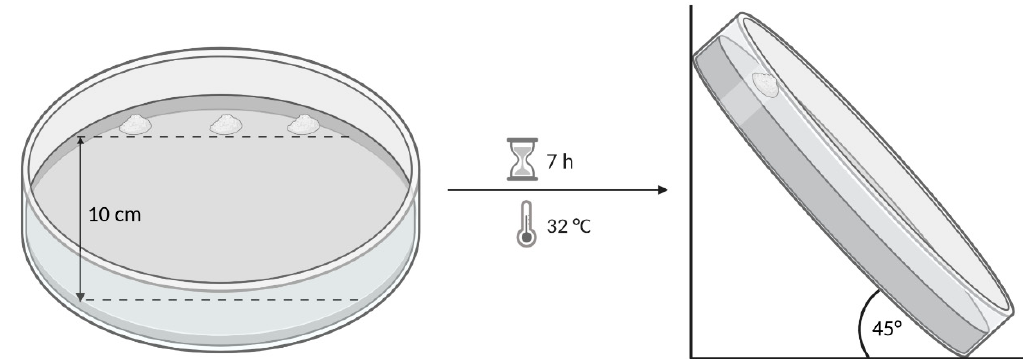
Figure 1. Schematic illustration of the experimental setup.